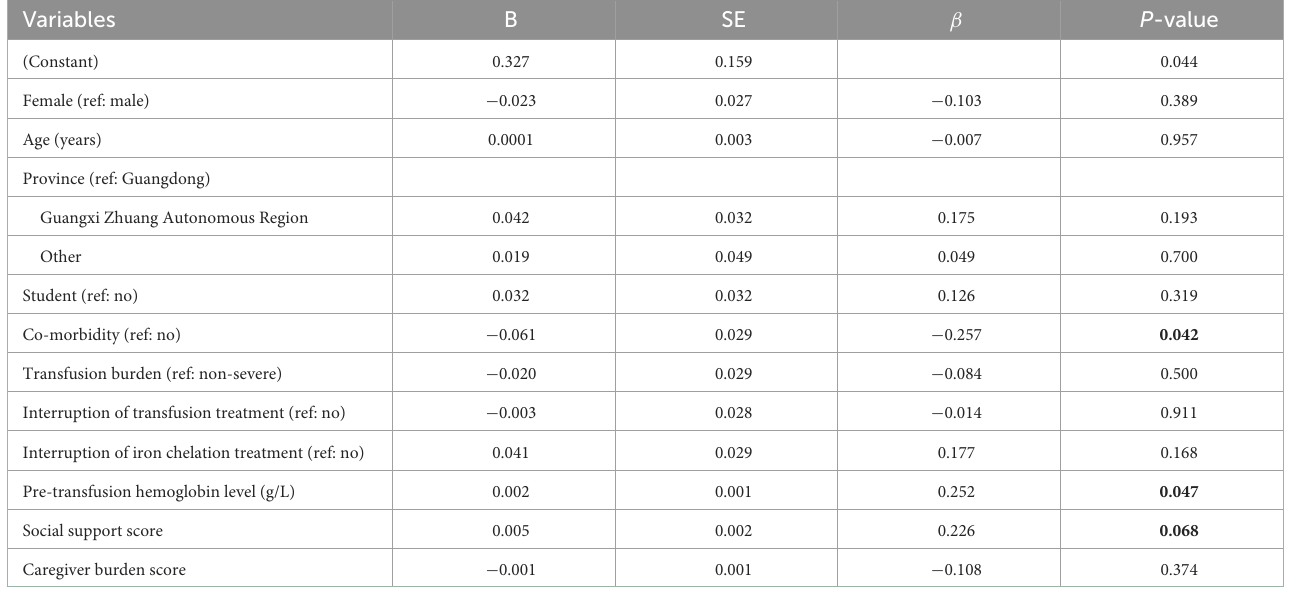
TABLE 4 Multivariable regression models for factors associated with SF-6D utility scores for adult patients with β -thalassemia major ( n = 75). Variables